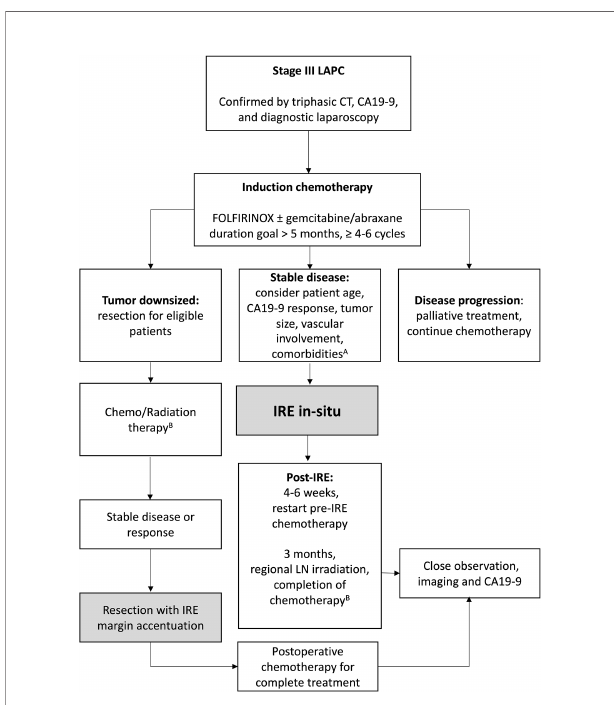
FIGURE 3 | Patient selection algorithm. A) Optimal patient selection criteria: Age ≤ 61, normalized CA19-9 at IRE, tumor size < 3.6cm, ≤ 180° vascular involvement, less than 2 co-morbidities, and those without diabetes mellitus. B) Can continue FOLFIRINOX (per PRODIGE trial). Chemotherapy goal 12 cycles of FOLFIRINOX, 18 total doses